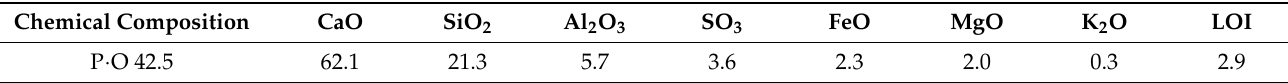
Table 1. Chemical composition of cement (%).